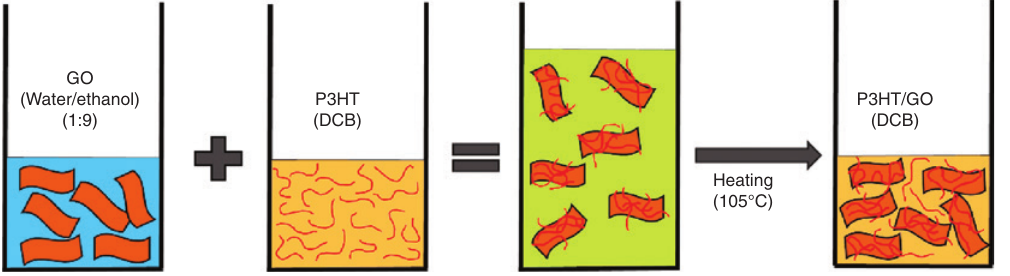
Figure 1: Schematic of the fabrication process for preparing P3HT/GO (DCB) dispersions by ethanol mediated mixing and evaporation